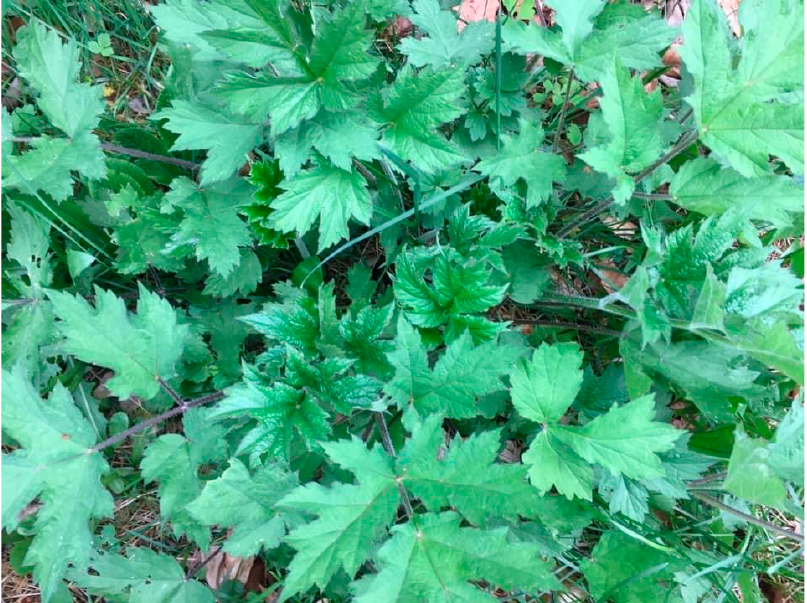
Figure 1. Plants of hogweed ( Heracleum sphondylium L.). Picture by Eleonora Matarrese.